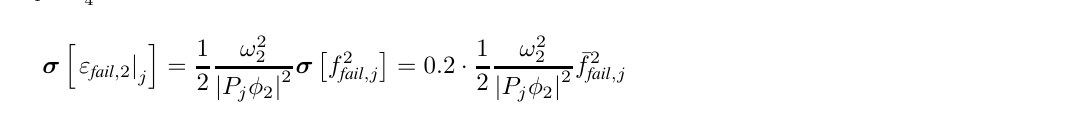
Fig. 3. Limit state surface and MPP for failure of spring 2 in structure 1 with Z 4 = Z ∗ 4 .